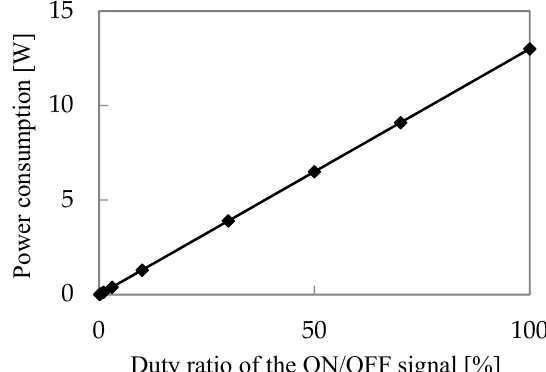
Figure 5. The dependence of the power consumption of the excimer lamp on the duty ratio of the ON/OFF signal.